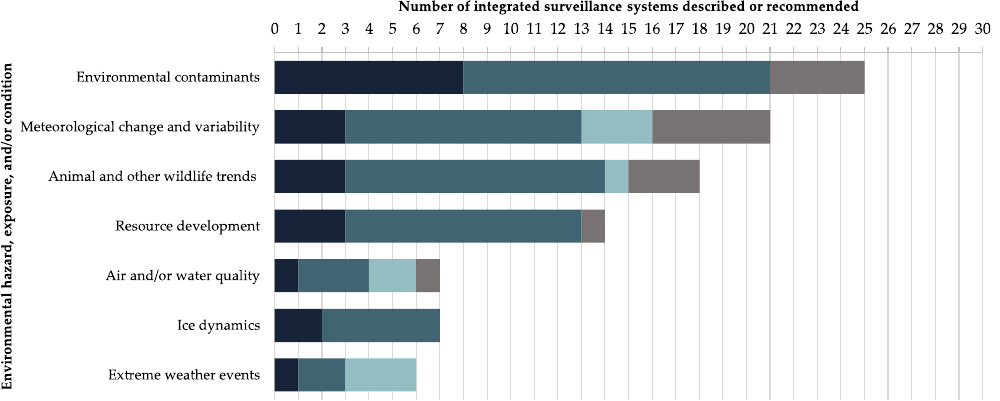
Figure 5. The main environmental hazards, exposures, and/or conditions included in integrated surveillance systems designed or recommended for Circumpolar Arctic and Subarctic regions, stratified by level of surveillance operation, as reported in the literature. Categories are not mutually exclusive.